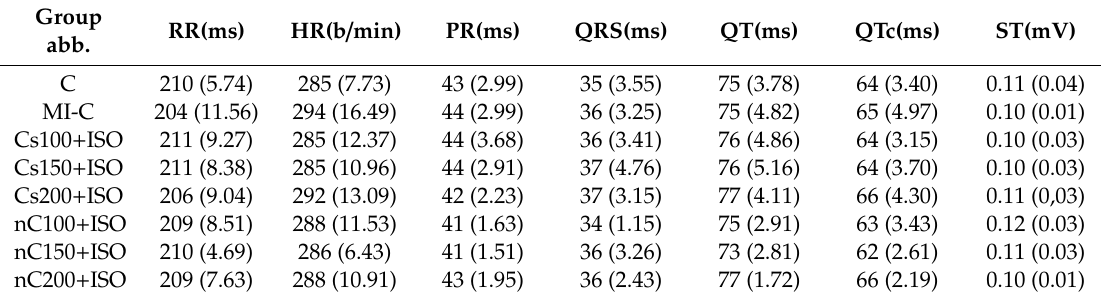
Table 2. Initial electrocardiogram (ECG) characteristics by group.